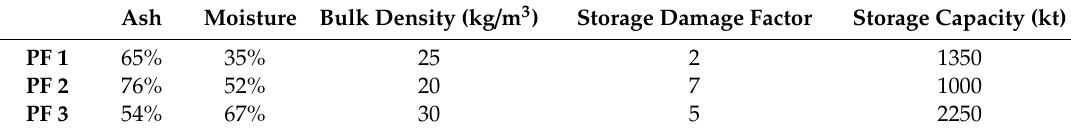
Table 4. Pretreatment Facility